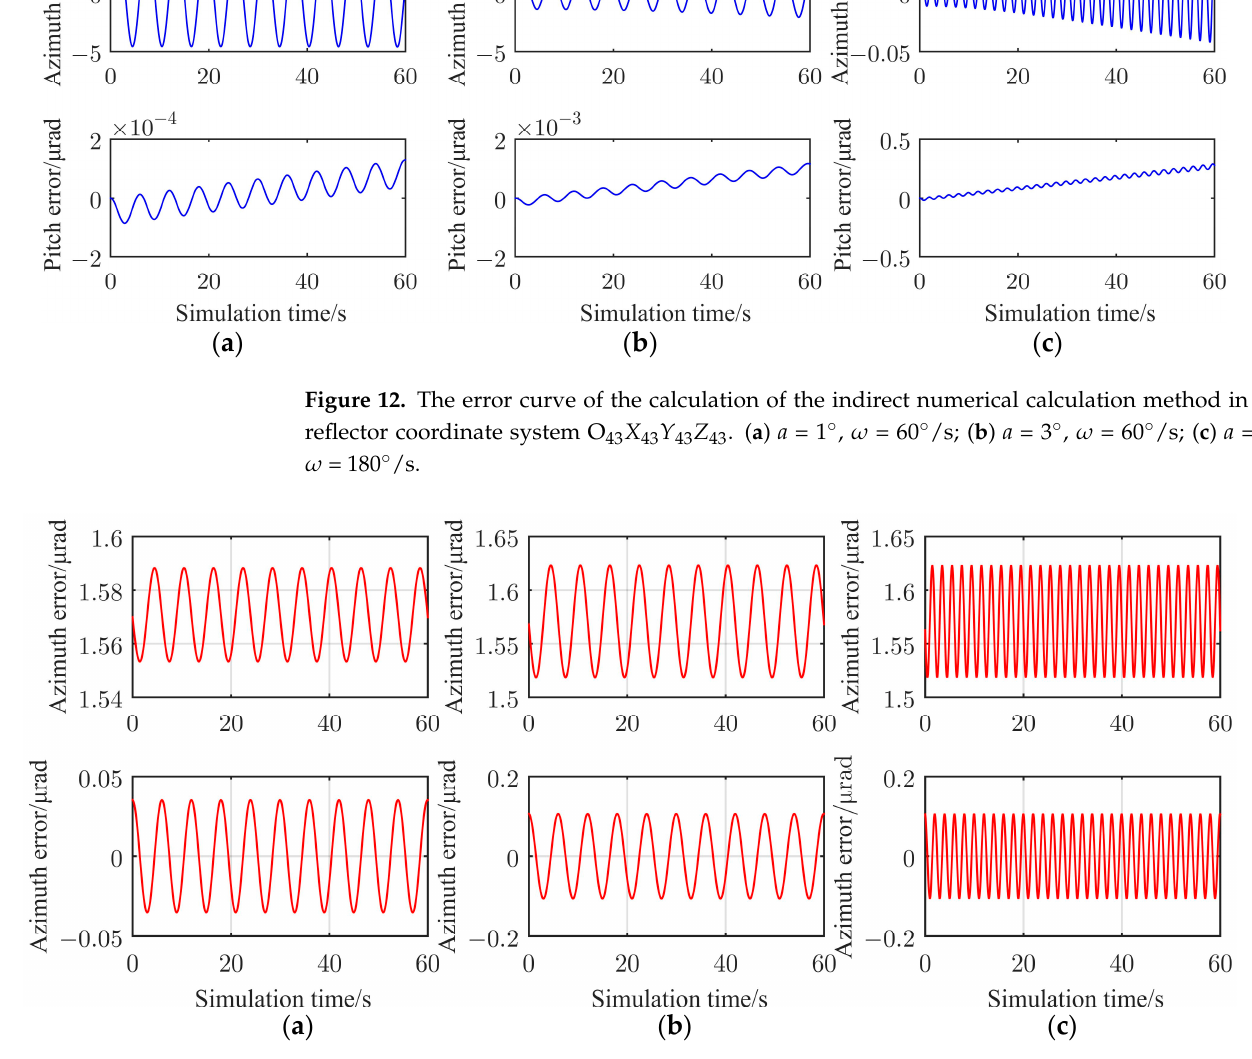
Figure 13. The LOS attitude curves under the condition of conical motion in an ideal state in the re fl ector coordinate system O 44 X 44 Y 44 Z 44 . ( a ) a = 1°, ω = 60°/s; ( b ) a = 3°, ω = 60°/s; ( c ) a = 1°, ω = 180°/s.